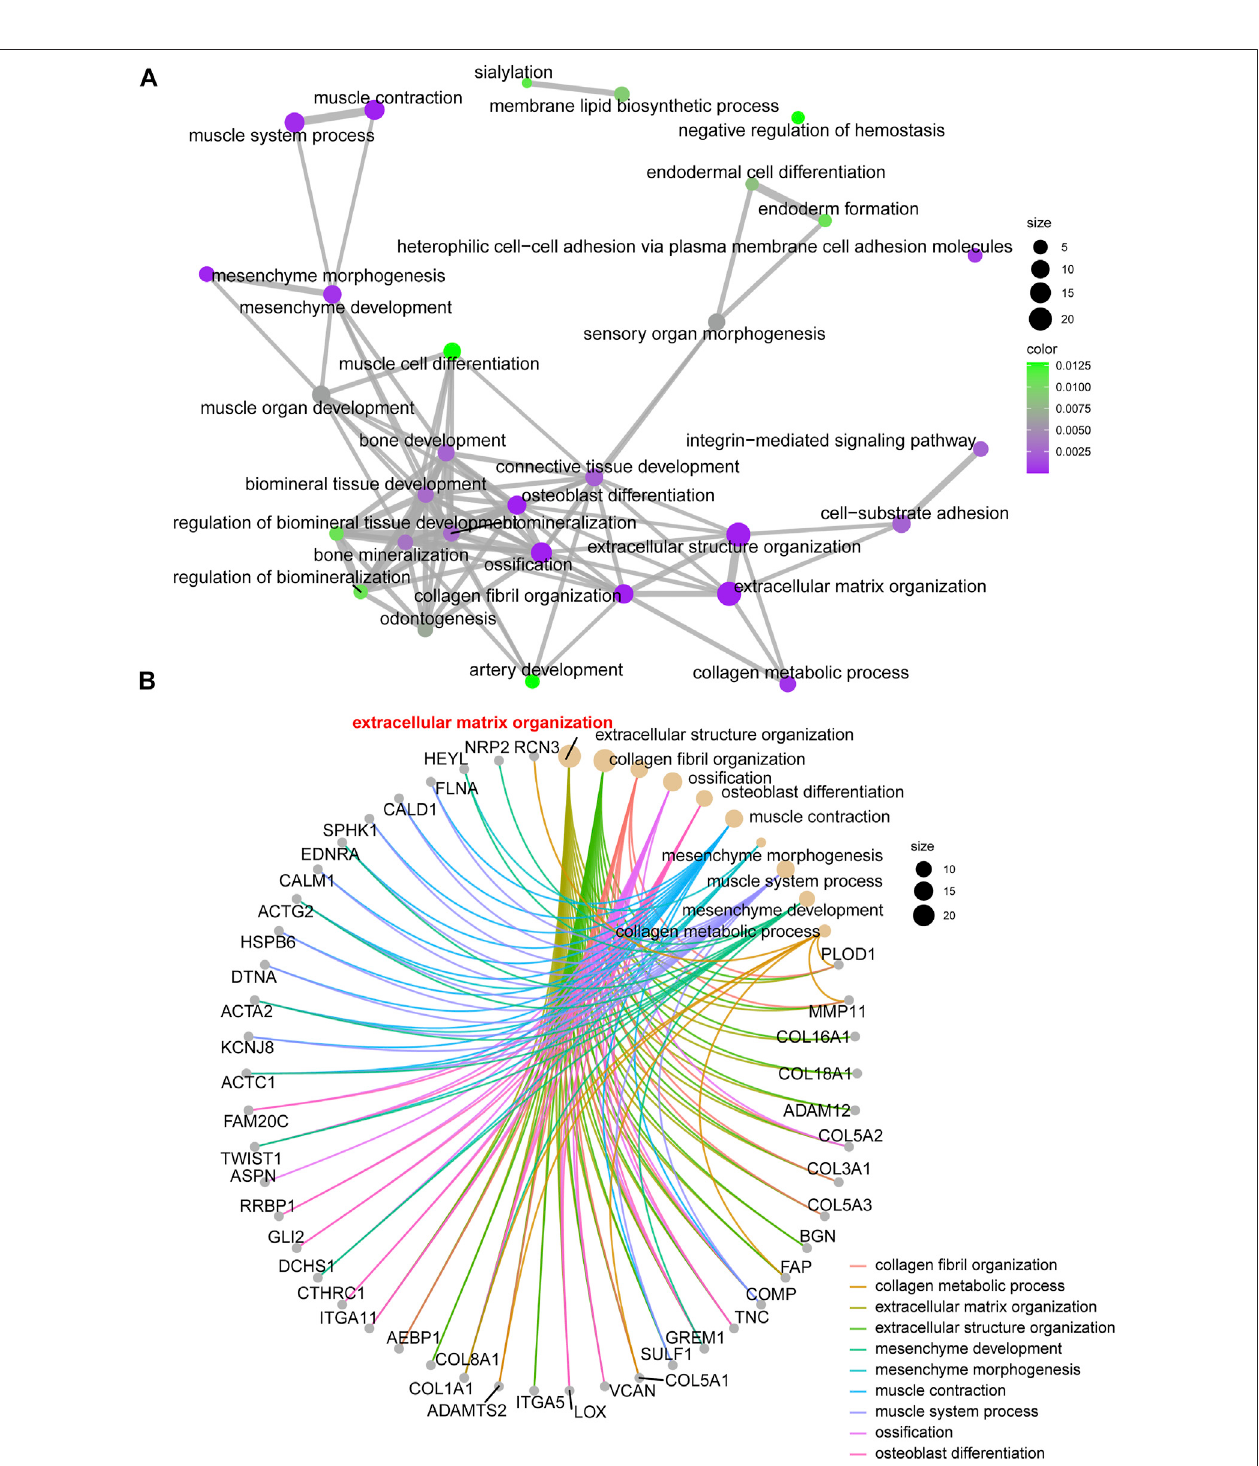
FIGURE 3 | The network and chord graph shows the most important pathways. (A) Network of enriched signaling pathways; (B) Chord graph of the enriched signaling pathways.